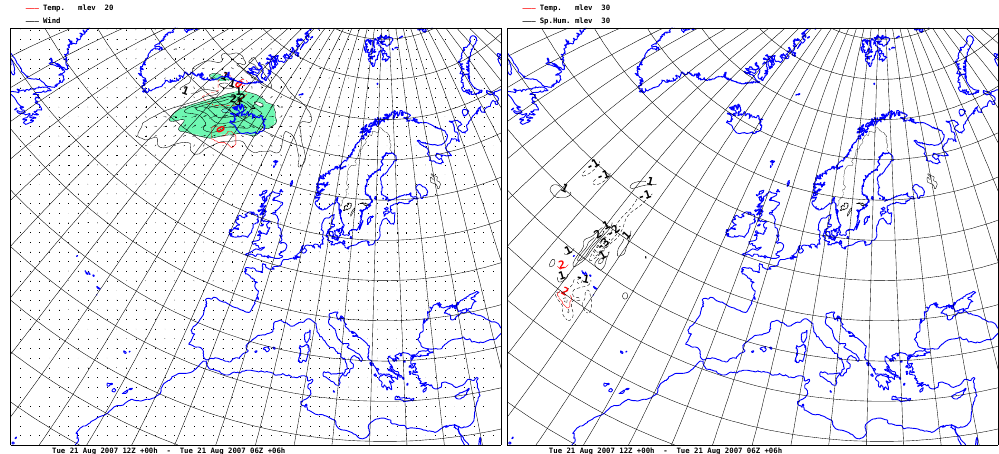
Fig. 5. Assimilation increments from single simulated observation experiments. Left figure: Wind and temperature increments at 300 hPa (a westerly wind observation increment of 5 ms − 1 was inserted on 300 hPa at 65 ◦ N 25 ◦ W), isoline spacing 1 ms − 1 and 1 K ; Right figure: Temperature and specific humidity increments at 850 hPa (temperature observation increment of 5 K was inserted on 850 hPa at 40 ◦ N 30 ◦ W), isoline spacing 0.1 K and 0.0001.